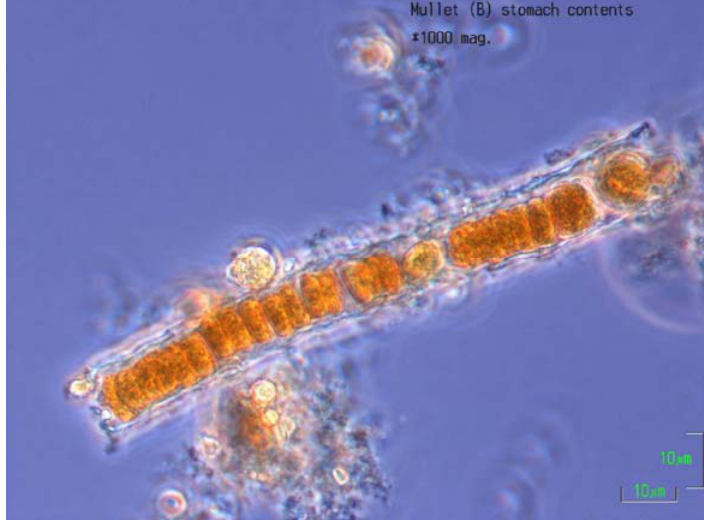
Figure 5. Nodularia trichome fragment from the stomach contents of a sea mullet ( Mugil cephalus ), study lake fish kill, November